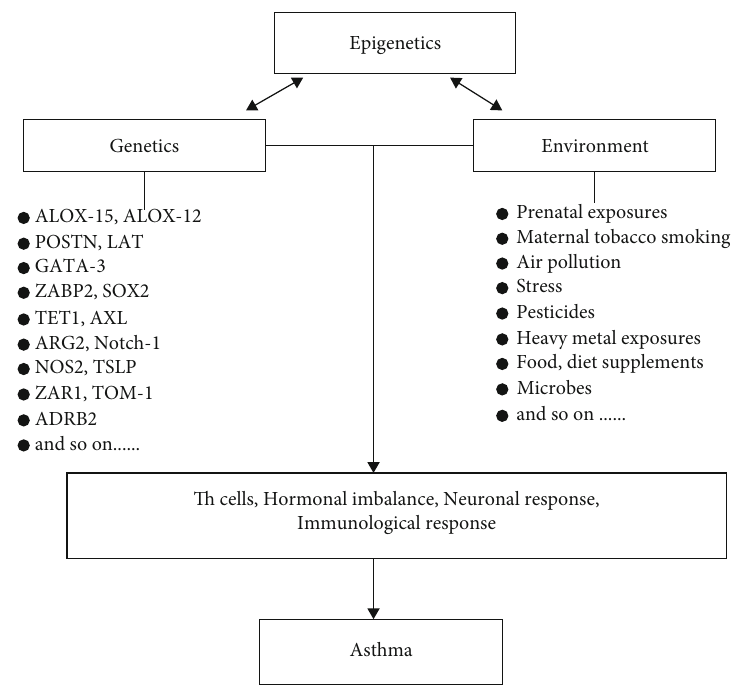
Figure 1: A schematic view showing the association between epigenetic mechanism and genetic and environmental factors in asthma. Genetics and environment are regulated by epigenetic factors. However, it is known that this interaction is more complex, and environmental factors, as well as genetic factors, can also regulate epigenetics. Several other components of the immune, neuronal, and hormonal response are also involved in the outcome. Th cells: T helper